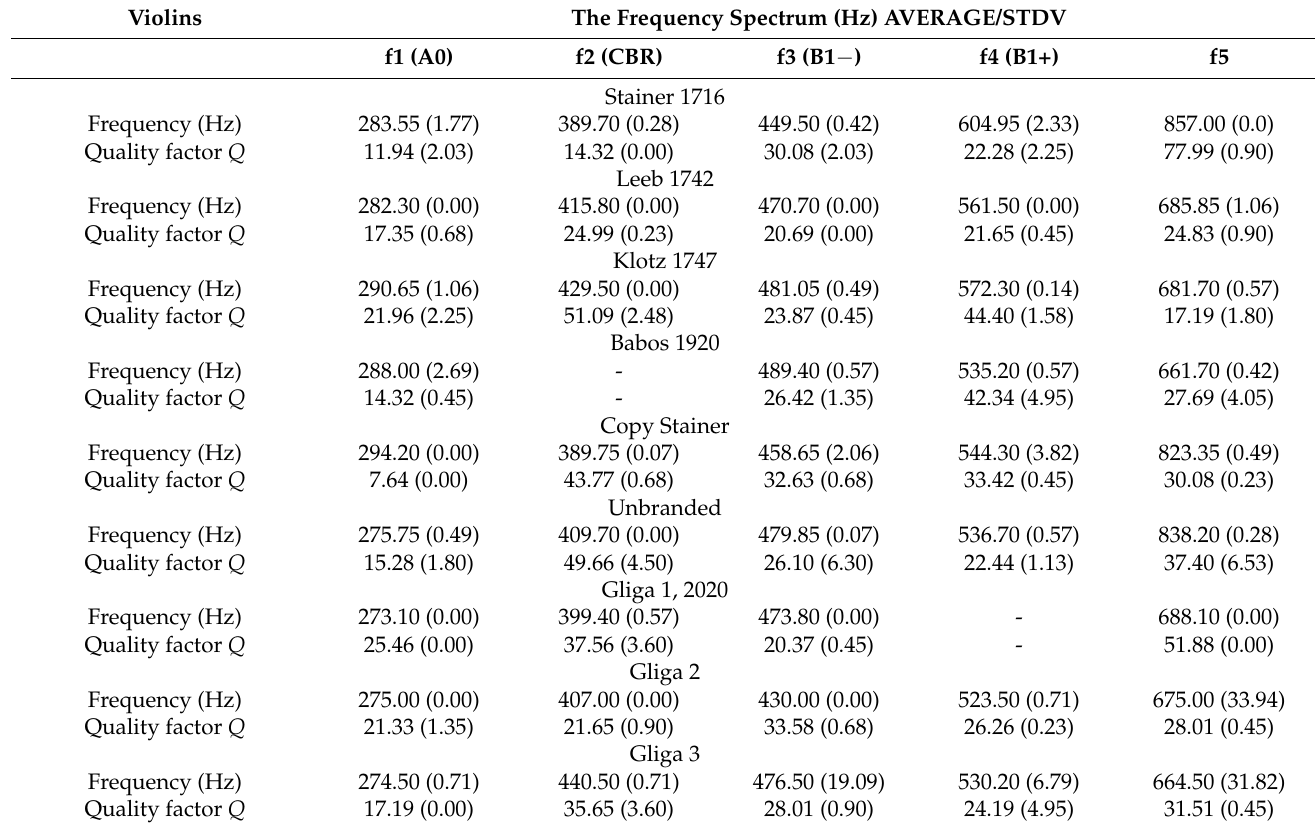
Table 3. Eigenvalues for the first vibration modes of old versus new